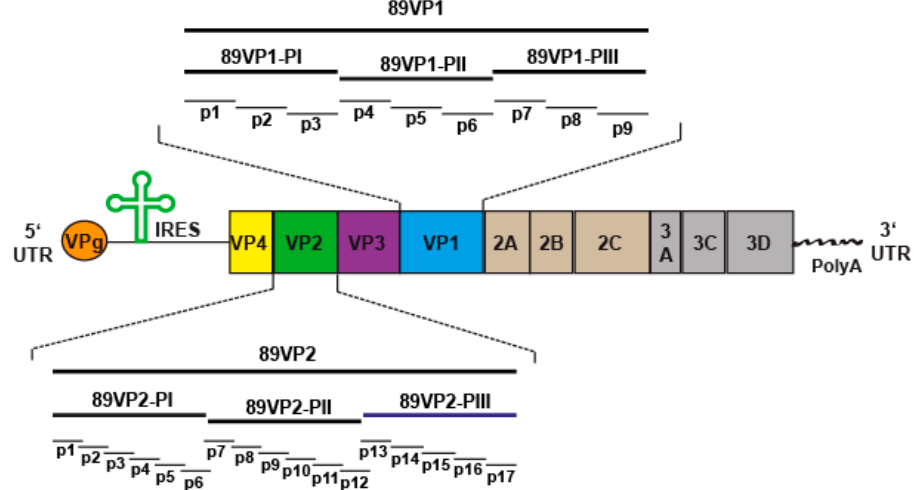
Figure 2. Schematic representation of the rhinovirus genome encoding a polyprotein. All structural (VP1, VP2, VP3, VP4) and non-structural proteins (2A, 2B, 2C, 3A, 3C and 3D) within the polyprotein are indicated. The 5 ′ UTR containing the IRES and the VPg sequences as well as 3 ′ UTR containing a poly(A) tail are also shown. The magnifications show the three recombinant fragments of VP1 (top) and VP2 (bottom) (i.e., PI, PII, PIII) as well as VP-derived synthetic peptides (i.e., VP1: p1-9;